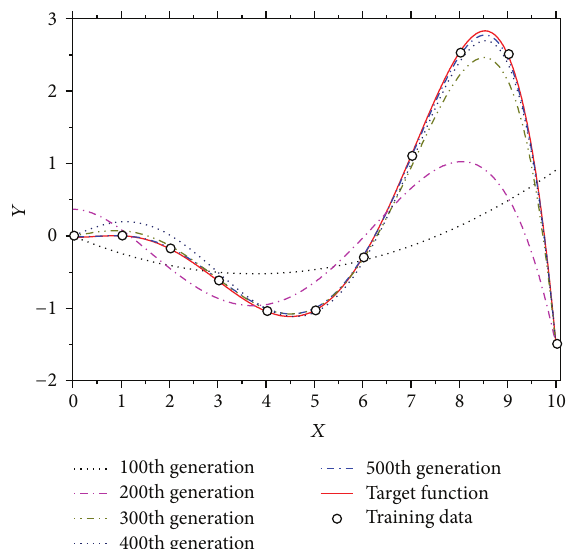
Figure 4: An example of symbolic regression. The error of the best individual is decreased as generation passes. The error can be calculated by summing the difference values between the actual data and the fitted data by